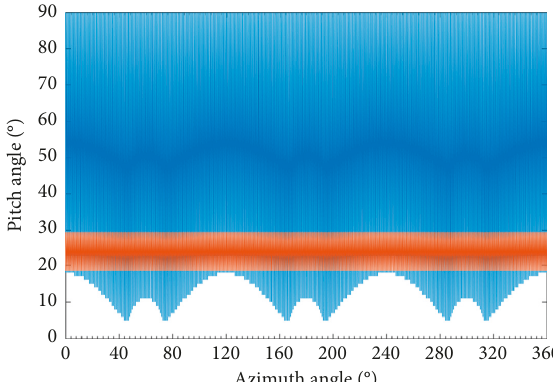
Figure 13: Moving scope of the TER pointing